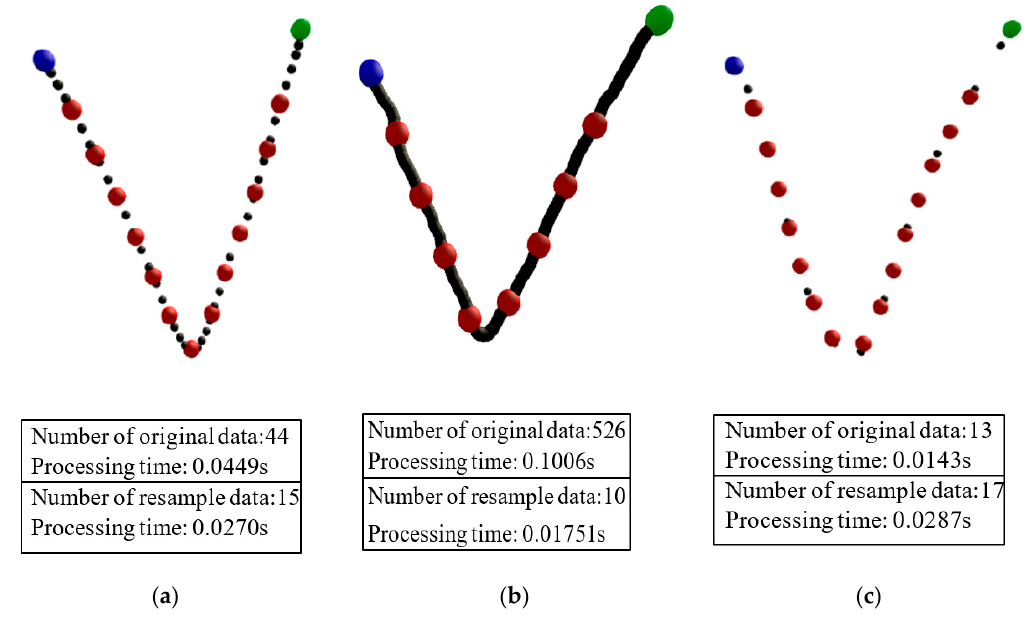
Figure 11. Recognition time for different moving speeds. ( a ) Normal-sampling; ( b ) over-sampling; and ( c ) under-sampling.